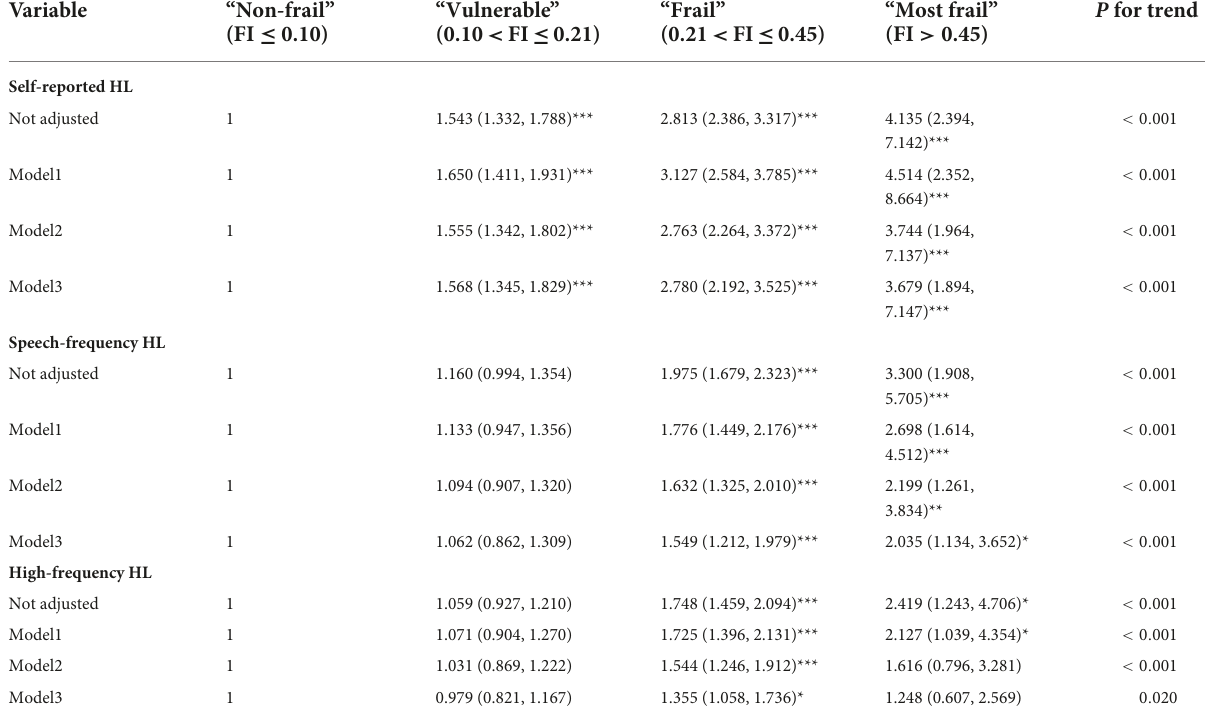
TABLE 2 Logistic regression models of frailty phenotypes as independent variables in the NAHANES study. Variable “Non-frail” (FI ≤